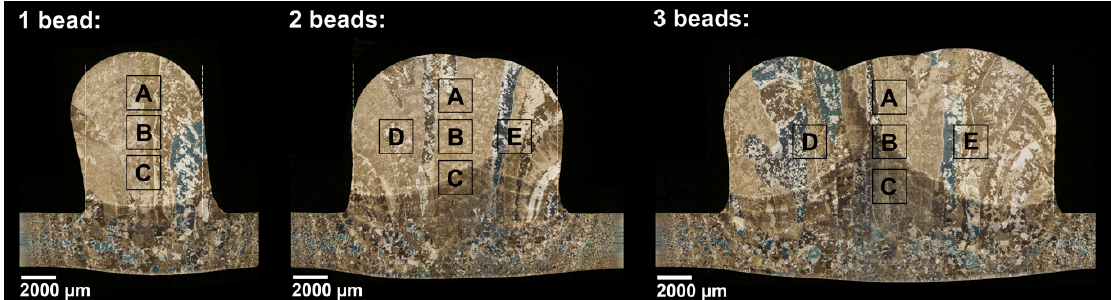
Figure 5. Light optical micrographs showing the characterized cross-sections indicated in Figure 1. The different areas, denoted as A, B, C, D, and E, correspond to the location of the measurements presented in Table 3.